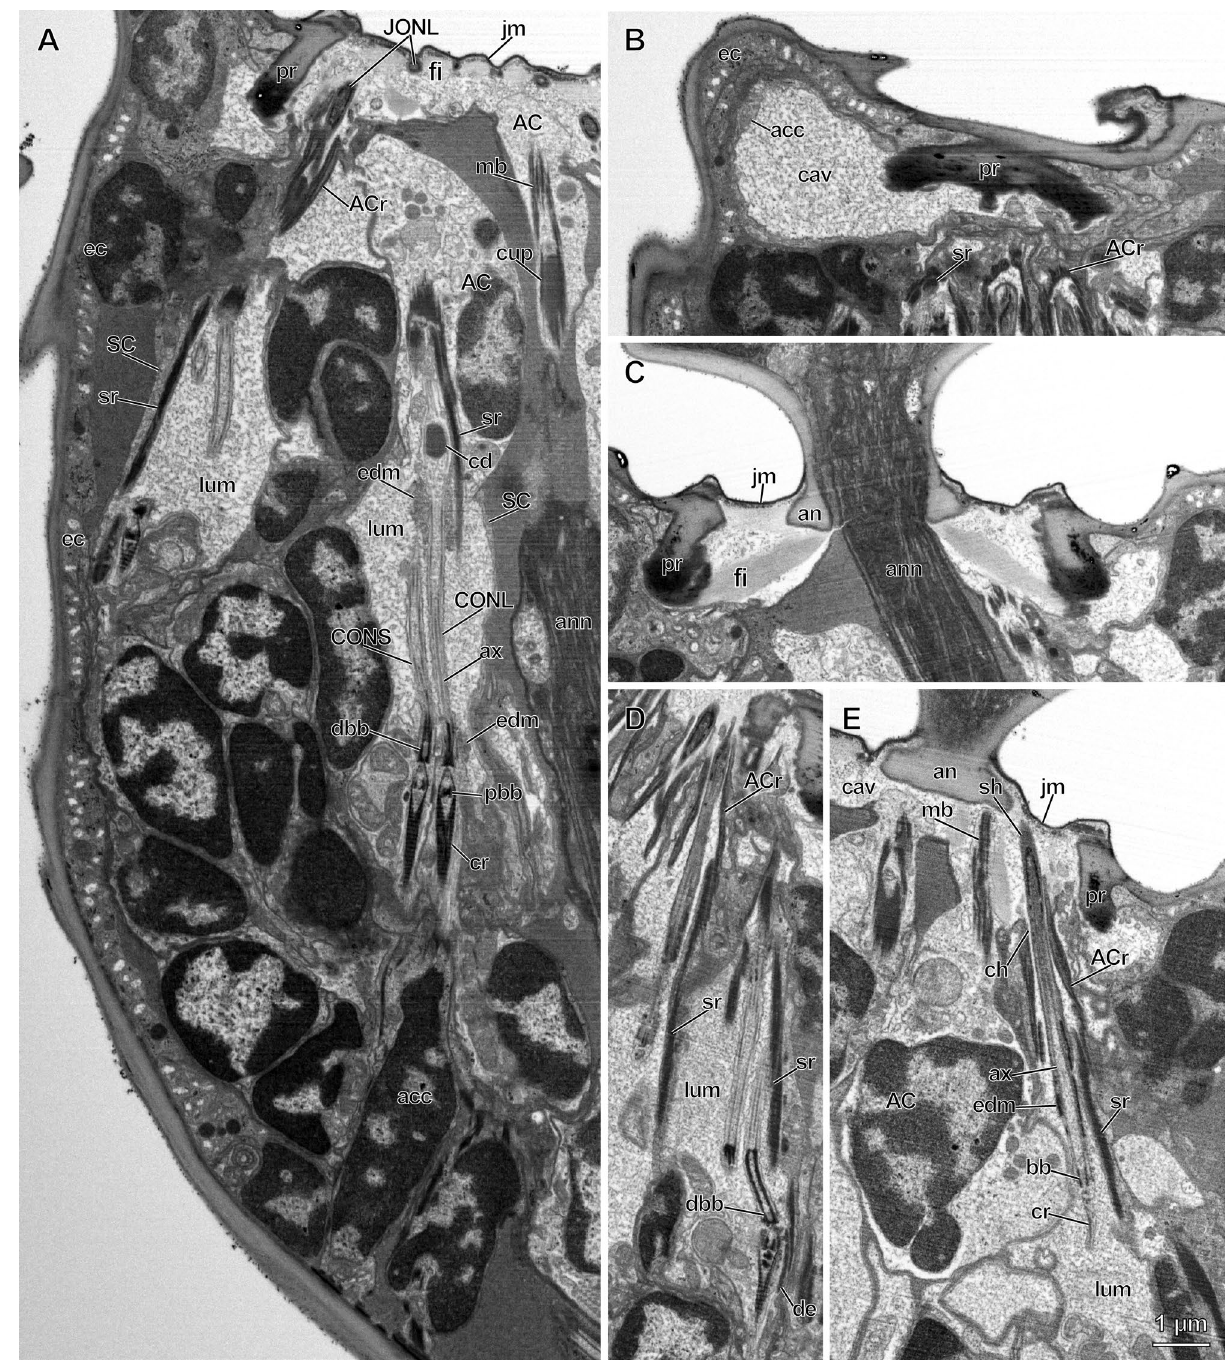
Figure 2. Longitudinal sections of pedicellar chordotonal organs in Megaphragma viggianii . ( A ) Median section of pedicel, showing the dorsal scolopidia. Basal bodies, cilia roots and axonemes are visible in central organ (CO) cilia which are surrounded by two bands of electron-dense material. Cilium dilation of long CO neuron (CONL) encloses a core. Scolopale cell (SC) form lumina, scolopale rods and cups. Attachment cells (AC) of Johnston’s organ (JO) form AC rods, and AC of CO form microtubule bundles. Cilia tips of long JO neurons (JONL) run alongside the invaginations of joint membrane between fibers. ( B ) Parasagittal section of the distal part of the pedicel. Accessory cell forms cavity filled with granular material. ( C ) Median section of the distal part of the pedicel. A joint membrane and fibers connect the pedicel rim and annelus. ( D ) Longitudinal section through the distal part of ventral JO scolopidia. A distinct bend of short JO neuron (JONS) cilium is observed. ( E ) Parasagittal section through the distal part of the pedicel. JONL contains only one basal body, a small ciliary root and an axoneme distally tapering in a bundle of microtubules. Its sheath-covered tip attaches to the annelus alongside CO AC. A narrow channel formed by the JO AC connects the lumen and cavity. (acc—accessory cell, ACr—AC rods, an—annelus, ann—antennal nerve,